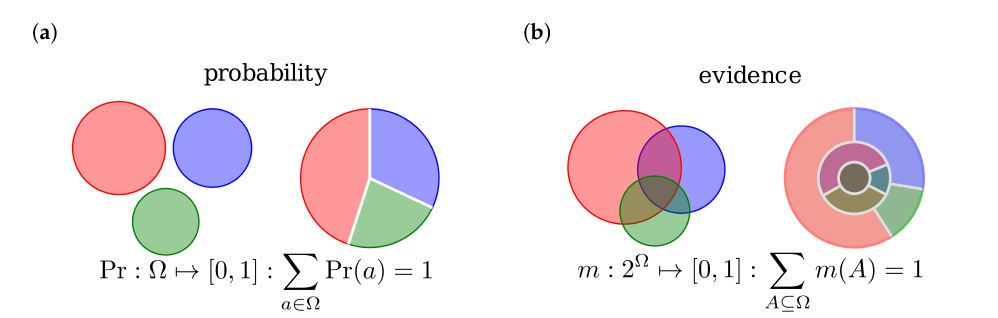
Figure 1. Graphical comparison between probability and evidence: ( a ) a distribution with probability function Pr ( a ) . ( b ) an evidence represented by a mass functions m ( A ) . Note, with three overlapping disks due to the lack of degrees of freedom (5 instead of 6) not all possible constellations can be graphically represented.